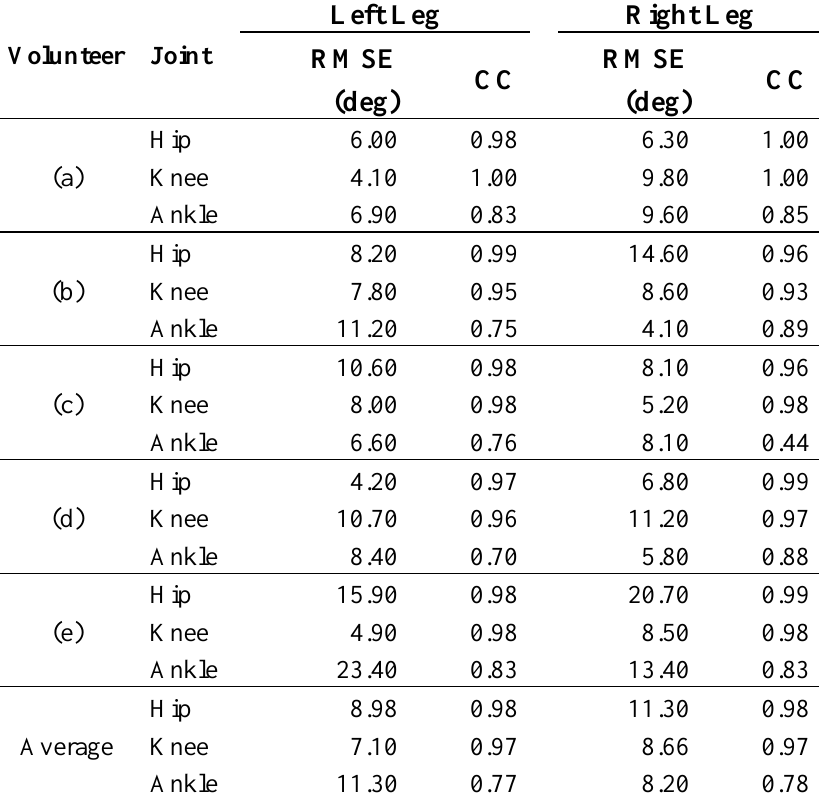
Table 2. Analytical results of the joint angles obtained from this study and camera